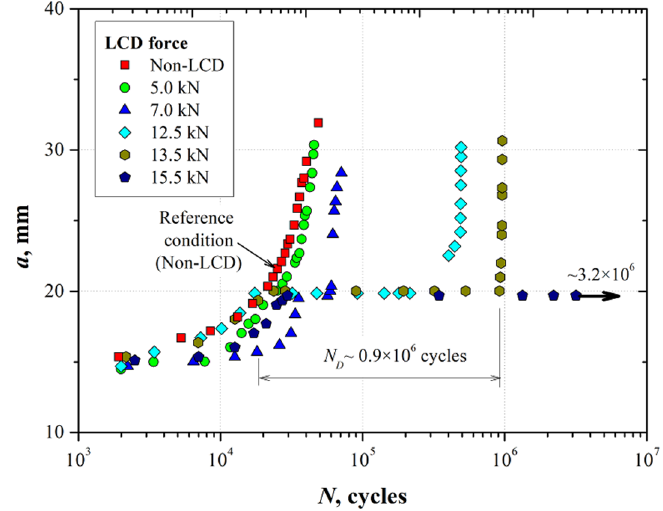
Figure 8. Crack length as a function of number of fatigue cycles for the 7075-T651 aluminum alloy specimens subjected to the localized compressive deformation process at the crack tip.